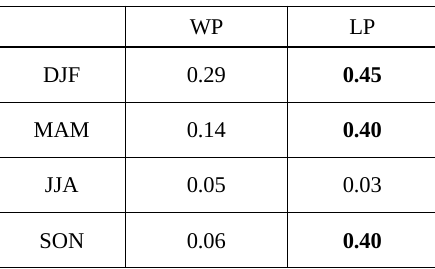
Table 1. Pearson correlation coefficient (r) between the monthly median of τ) classified by season and the accumulated precipitation anomaly for the March 2010 - November 2014 period for the WP and LP regions. Significant values at p < 0.15 level of confidence are marked in